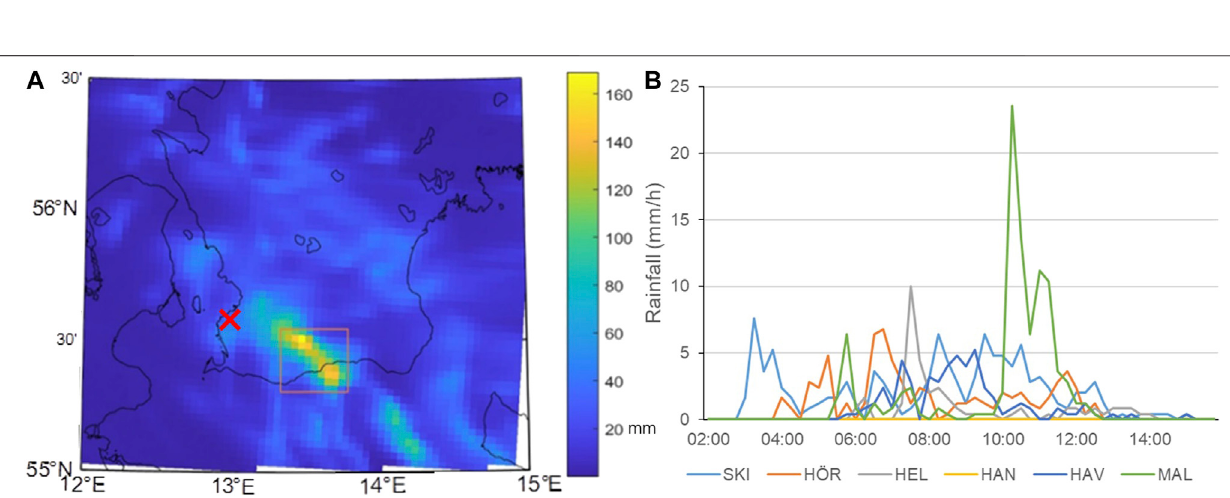
Frontiers in Earth Science |